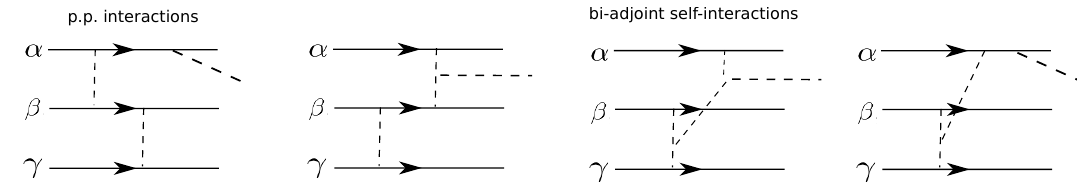
Figure 4 . Interactions contributing to the current at O (4). The left-hand side shows the contri- bution from the interactions between the point-particles and the bi-adjoint scalar (cid:12)eld. The center and right-hand side graphs show the contributions from the bi-adjoint scalar 3-point